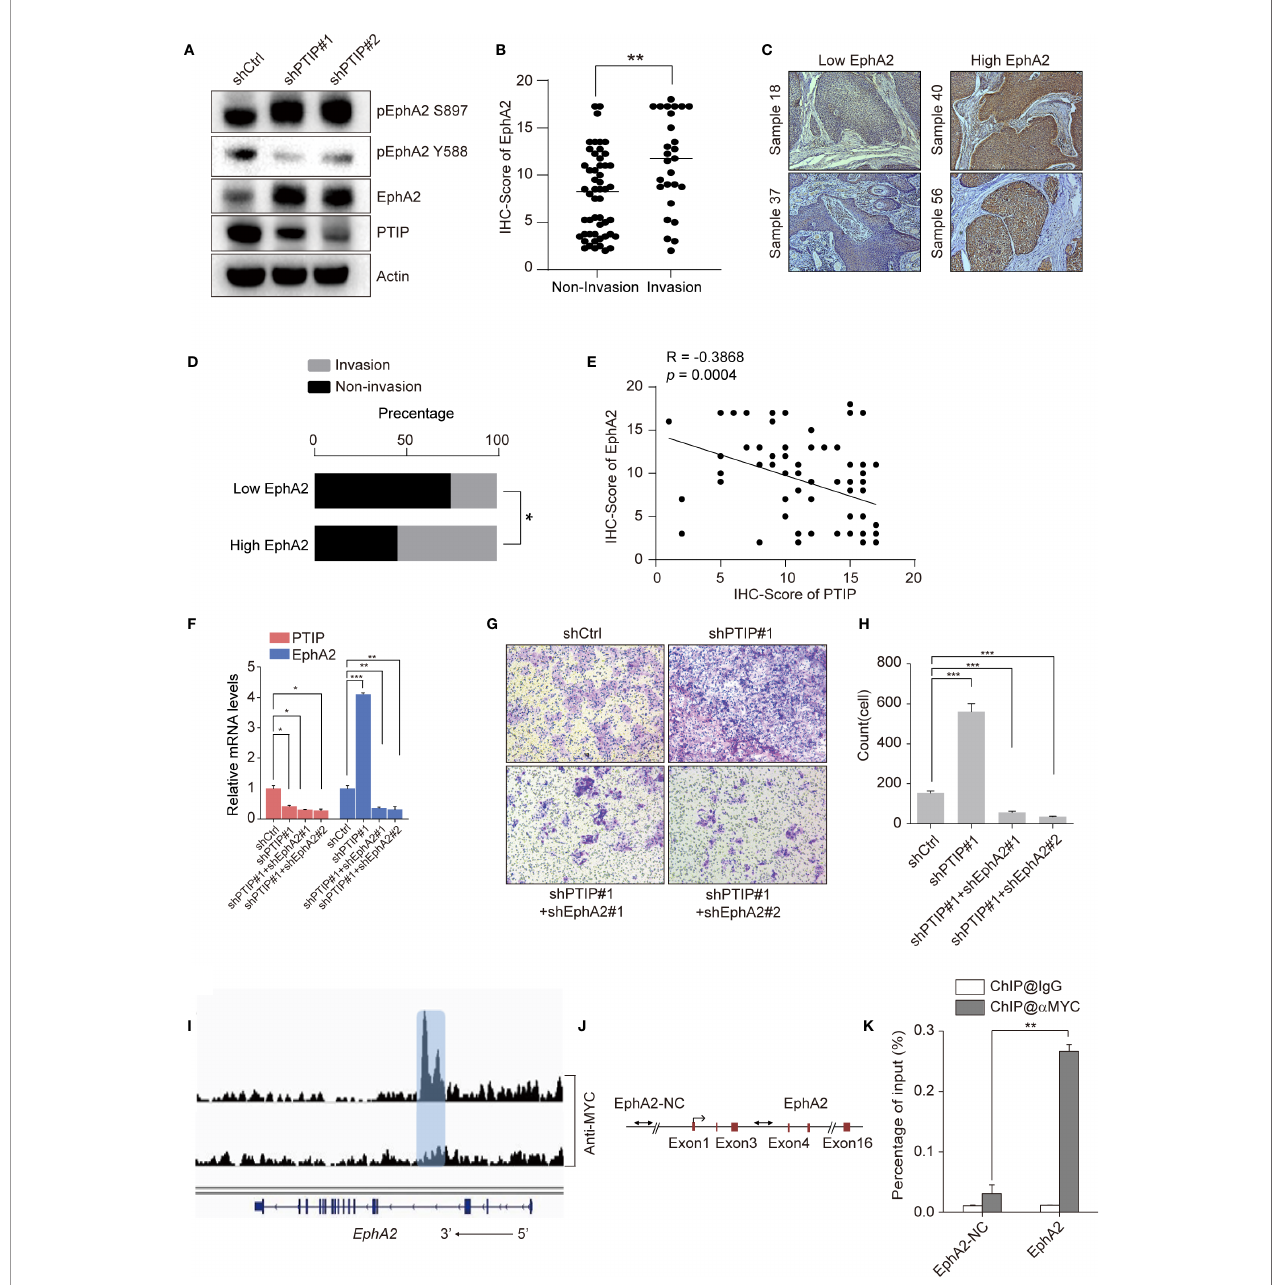
FIGURE 5 | PTIP inhibits ESCC cell invasion and migration through EphA2. (A) Western blotting analysis against PTIP, EphA2, pS897-EphA2, pY588-EphA2 in PTIP knockdown(shPTIP#1, shPTIP#2) and control (shCtrl) TE1 cells. (B) IHC score for EphA2 in ESCC tumor sections. Unpaired, two-tailed Student ’ s t-test; ** P < 0.01. (C) Representative IHC images for EphA2 in ESCC tumor sections. Low EphA2 and high EphA2 groups were divided based on the EphA2 immunostaining intensity scores mentioned in method. Cut off for high and low EphA2 expression in ESCC was de fi ned < or > 11. (D) Percentage of invasion and non-invasion in ESCC groups. The differences between rates were tested by c 2; * P < 0.05. (E) Comparative expression between PTIP and EphA2 in ESCC samples from (B) analyzed by Pearson correlation. (F) Knockdown ef fi ciency of shRNAs targeting PTIP and EphA2 in TE1 cells as determined by qRT-PCR. One-way ANOVA; * P < 0.05,** P < 0.01, *** P < 0.001. (G, H) The effect of PTIP and EphA2 double knockdown on the invasiveness of TE1 cells. For invasion assay, six different microscopic fi elds (magni fi cation, ×10) from at least three independent experiments were examined; Relative intensities of the fi elds were measured (n ≥ 3). Representative images and statistical plots are shown; Mean ± s.d. are given for three independent experiments. One-way ANOVA; *** P < 0.001. (I) ChIP-seq density pro fi les for PTIP in TE1 cells. Gene models are shown below the density pro fi les. (J, K) ChIP-qPCR primer sets marked with arrows were designed to cover regions present within (EphA2) or outside (EphA2-NC) of the EphA2 gene (C) . ChIP-qPCR analyses of EphA2 binding (D) . Representative images and statistical plots are shown; Mean ± s.d. are given for three independent experiments. Unpaired, two-tailed Student ’ s t-test; ** P <